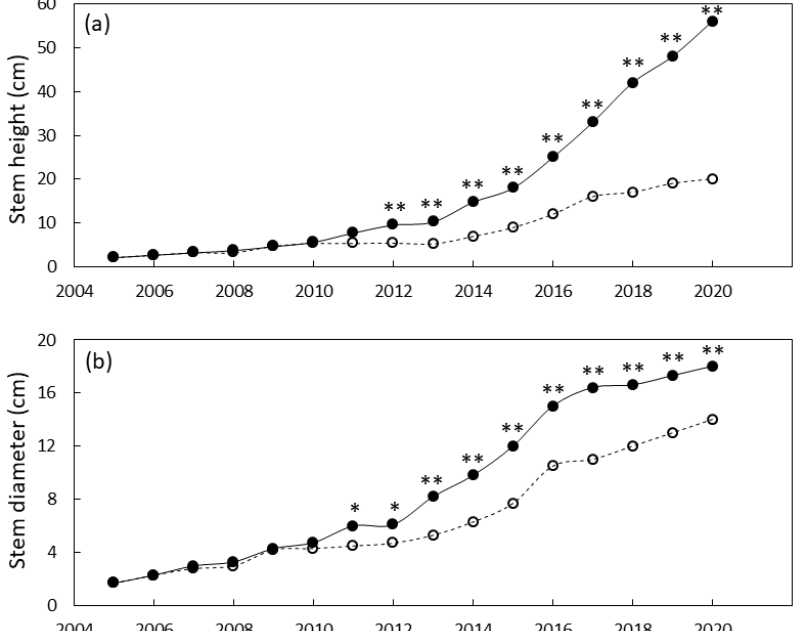
Figure 4. Size of Cycas micronesica plants growing in a south Guam garden over a 15 y growth period. ( a ) stem height and ( b ) basal stem diameter. Closed circles are local genotypes, open circles are foreign genotypes. * = significant at p ≤ 0.05, ** = significant at p ≤ 0.01.